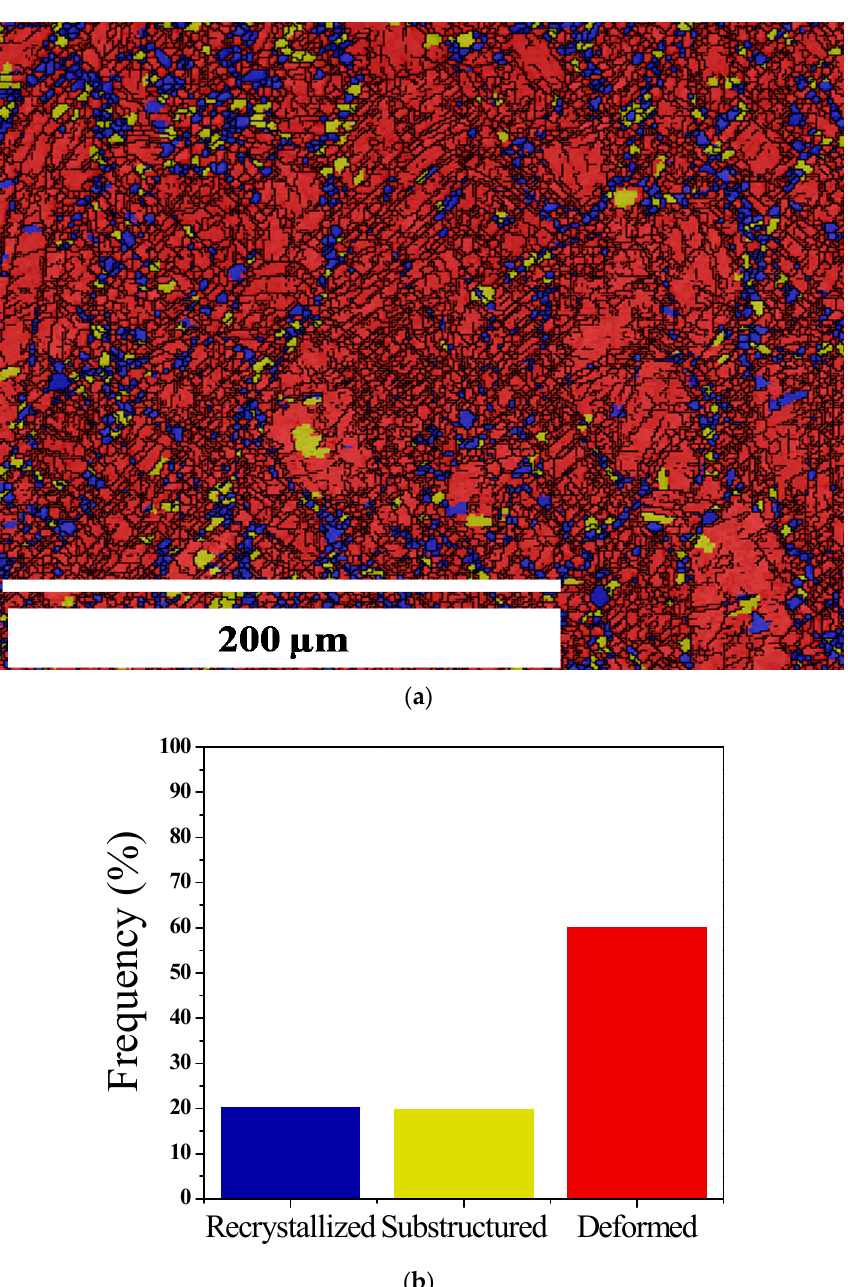
Figure 4. Recrystallized fraction for Sample A with delta-processing treatment and deformation: ( a ) recrystallized grains (blue), substructured grains (yellow), deformed grains (red); ( b ) frequency (in %).